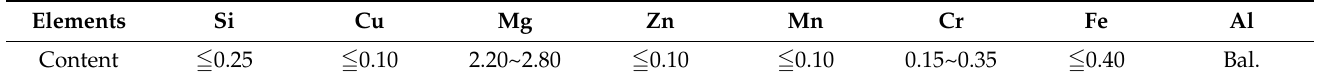
Table 1. Composition of AA5052 (mass fraction, %) [20].